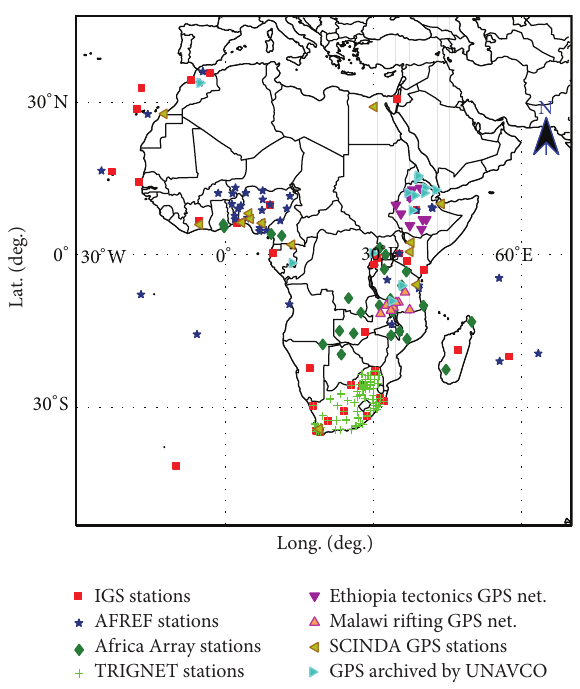
Figure 7: Distribution of IGS and AFREF stations and other GNSS stations/networks in